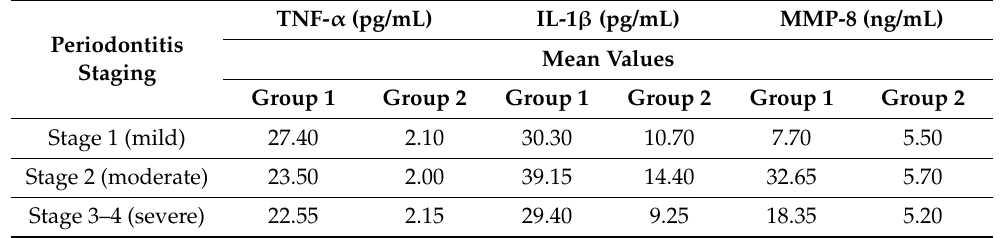
Table 5. GCF immune biochemical biomarker levels in study group versus control group in corre- spondence to periodontitis staging.